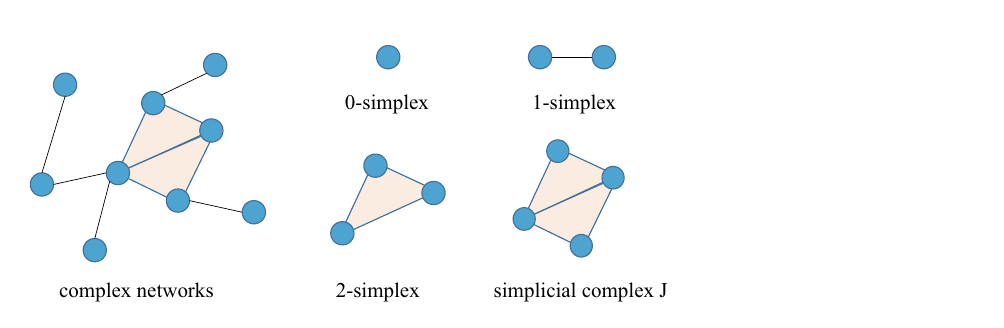
Figure 3. Examples of different types of simplex structures in